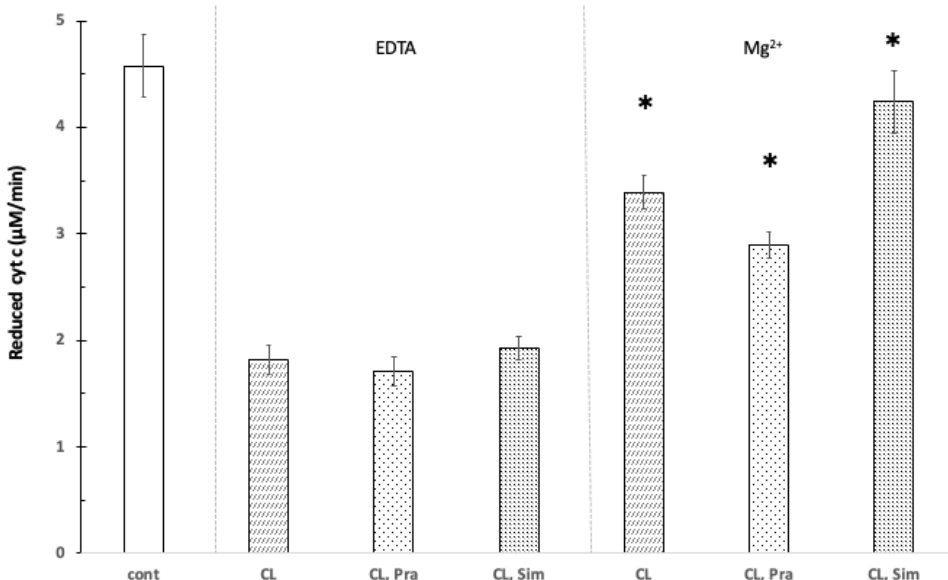
Figure 3. The effect of pravastatin and simvastatin on the reduction of cytochrome c in the presence of cardiolipin. Control without cardiolipin, pravastatin, and simvastatin (cont); 200 μ g/mL cardiolipin (CL), 100 μ M cytochrome c, 100 μ M pravastatin (Pra), 100 μ M simvastatin (Sim), 100 mM Tris/HCl (pH 8.0), 1 mM Mg 2+ (Mg), 1 mM EDTA (EDTA), T = 25 °C. * shows significant difference.